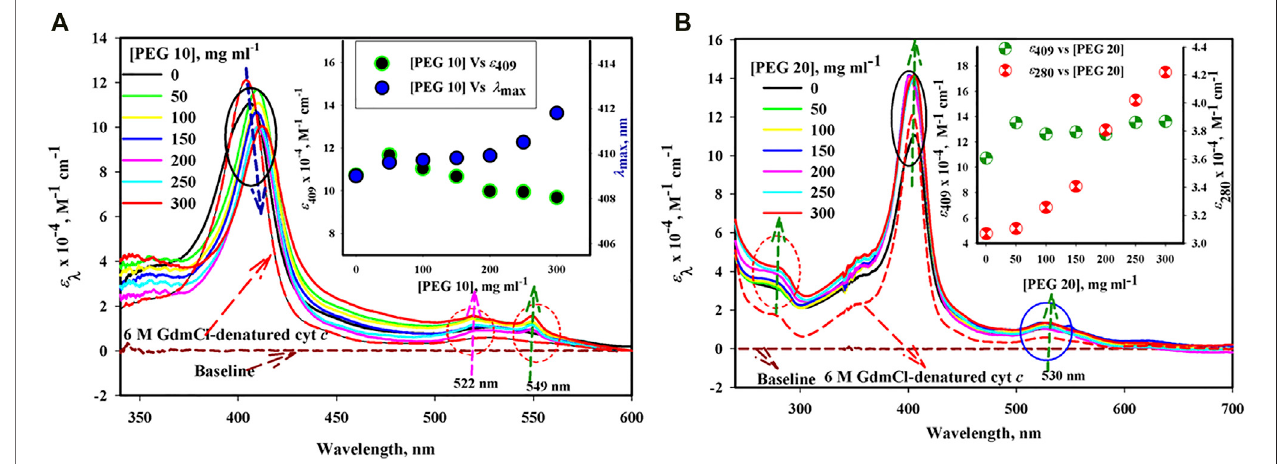
FIGURE 1 | Absorption spectra of cyt c in the presence of various concentrations of (A) PEG 10 and (B) PEG 20. Inset of Figure (A) gives plot of ε 409 and λ max against [PEG 10]. Inset of Figure (B) gives plot of ε 409 and ε 280 against [PEG